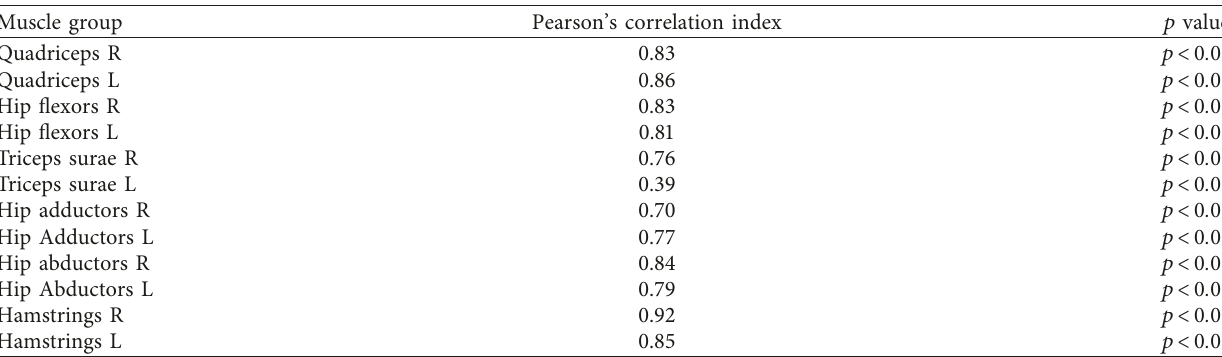
Table 3: Test-retest: validity outcomes.